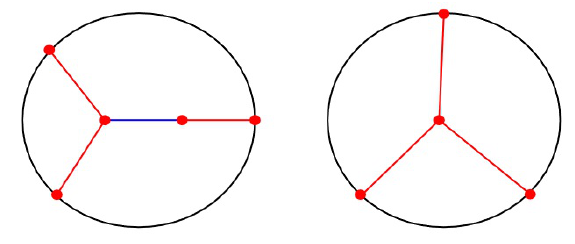
Figure 3. Three point Witten diagrams. Red lines denote bulk to boundary propagators; blue line denotes bulk to bulk